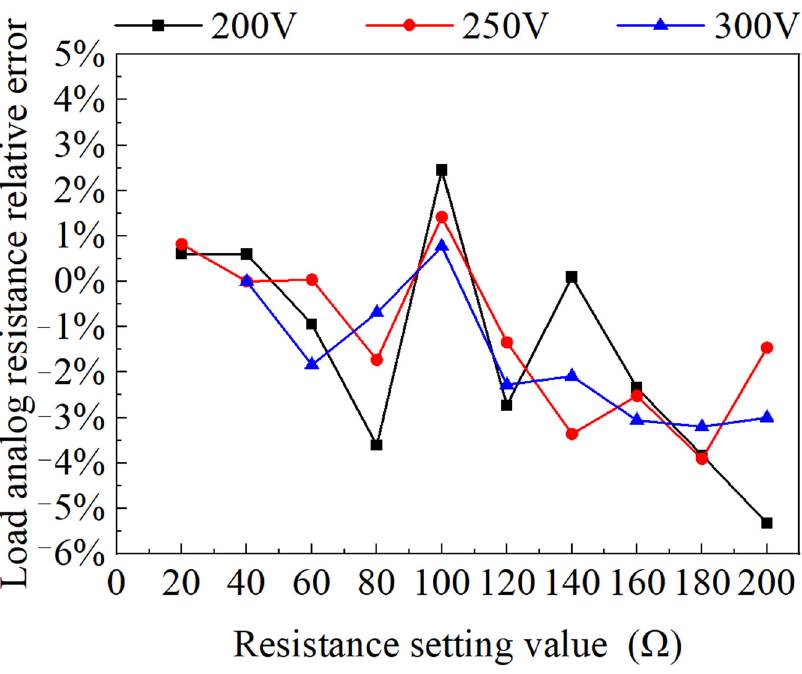
Figure 14. Load analog resistance relative error curve.